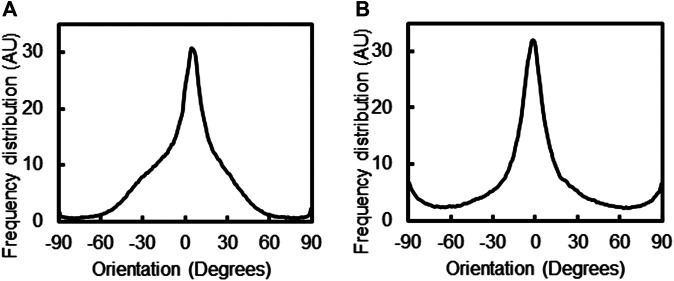
Alignment and orientation of fiber composites. The alignment of PVDF fibers (A) before, and (B) after 18 h of PPy polymerization coating was assessed by orientation distribution of fibers, measured using the OrientationJ plugin of ImageJ.